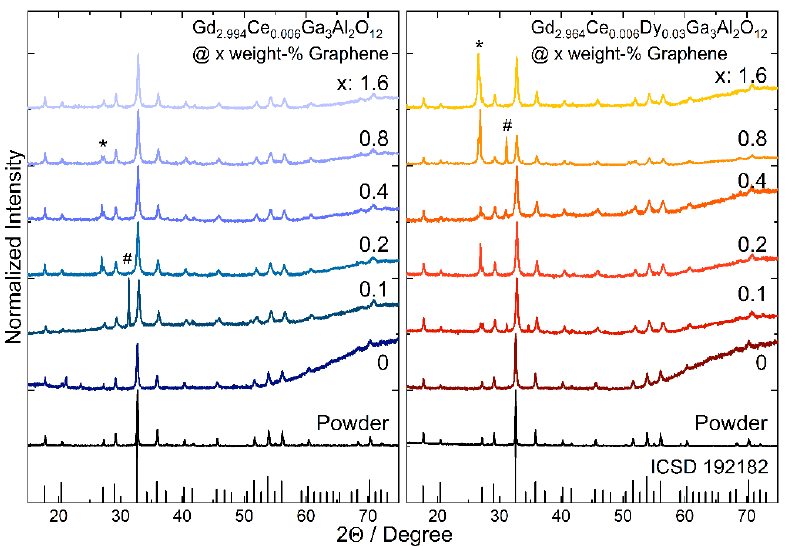
Figure 1. XRD patterns of Gd 2.994 Ce 0.006 Ga 3 Al 2 O 12 and Gd 2.964 Ce 0.006 Dy 0.03 Ga 3 Al 2 O 12 powders and ceramics with different graphene content (*—graphite, #—abrasive MgAl 2 O 4 ). The representative SEM images of the Gd 2.994 Ce 0.006 Ga 3 Al 2 O 12 and Gd 2.964 Ce 0.006 Dy 0.03 Ga 3 Al 2 O 12 ceramics with different graphene content are shown in Figure 2. It